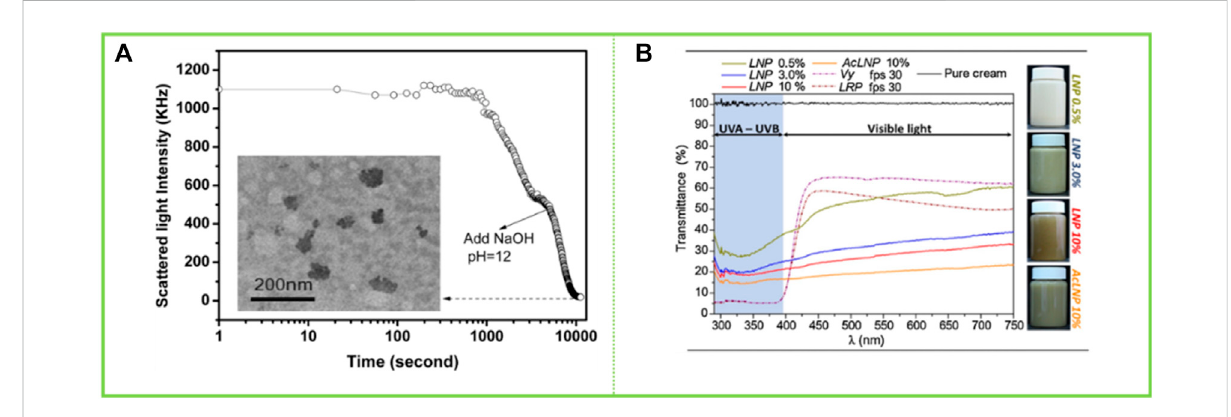
FIGURE 11 (A) Scattered light intensity of the ACL colloidal suspensions with addition of NaOH as a function of storing time (Qian et al., 2014b) (B) UV – vis transmittance of neutral creams blended with LNP (0.5, 3.0 and10 wt%) and ACLNP (10 wt%) in comparison to commercial sunscreens with fps 30 (LRP = La Roche-Posay ® and Vy = Vichy Laboratories ® ) (Trevisan and Rezende, 2020). (A) Copyright 2014 Royal Society of Chemistry (B) Copyright 2020